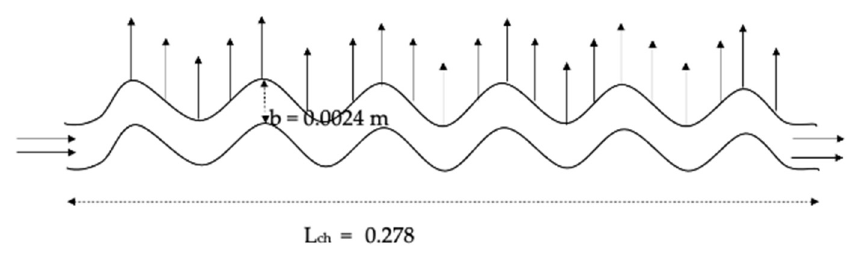
Figure 4. Schematic diagram of the numerical domain.